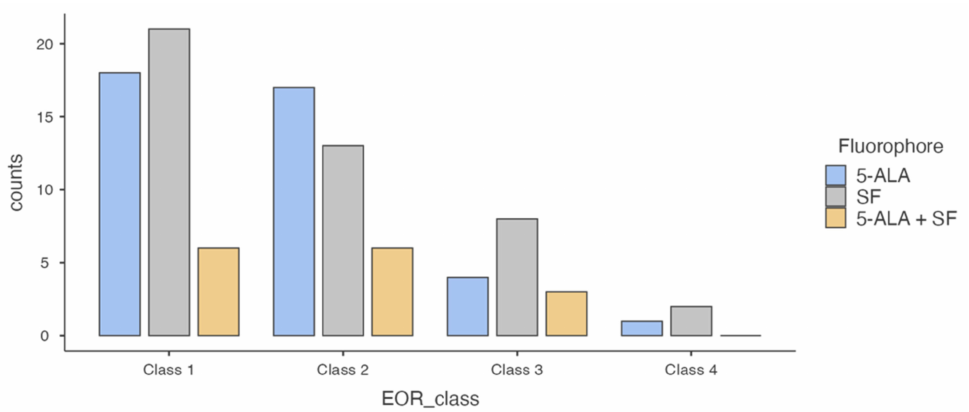
Figure 1. Graph of different distribution of fluorescent dyes among EOR classes. Class 1 represents 100% of resection of the contrast-enhanced nodule; 99–90% for class 2, 89–80% for class 3 and less than 80% for class 4. An EOR of more than 90% (class 1 and 2) was obtained in 35/40 patients where 5-ALA was used as fluorophore, in 34/44 for SF and 12/15 for both. No statistically significant associations were identified between the fluorophore and EOR ( p = 0.783). The results do not reach statistical significance even by aggregating the EOR classes and setting the limit to 100% ( p = 0.872) and 90% ( p = 0.469). Similarly, a statistical significance was not reached, either by comparing only those patients where a single fluorophore was employed ( p = 0.523) or by stratifying by MGMT promoter status ( p =